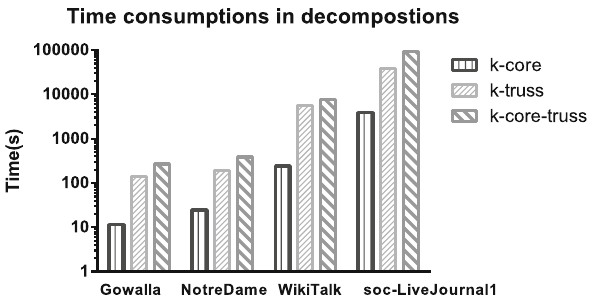
Fig. 6 Running time in three graph decompositions: k -core decom- positions, k -truss decompositions and k - core - truss